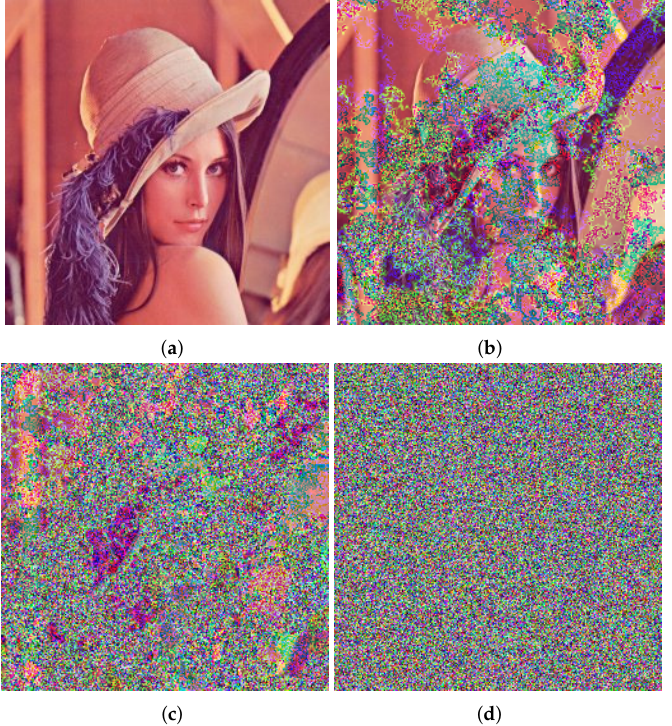
Figure 6. Examples of Lanton’s ant. ( a ) Input RGB image. ( b ) Result after 100,000 steps. ( c ) Result after 300,000 steps. ( d ) Result after 1,500,000